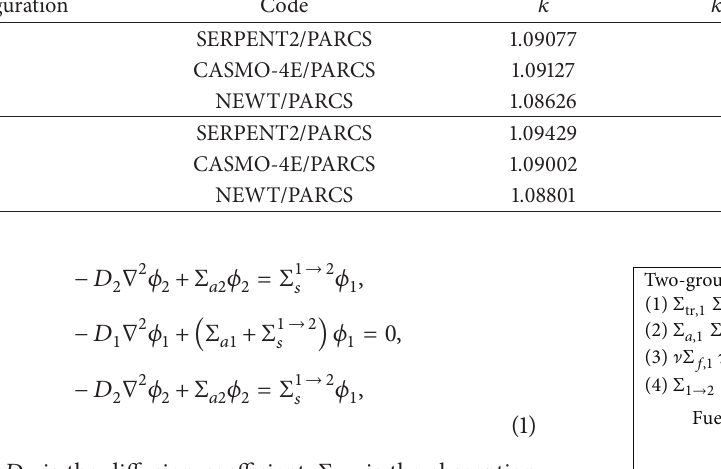
Table 5: The eigenvalue of DIMPLE S06 criticality benchmark by 2D two-step modeling without ADF. Configuration